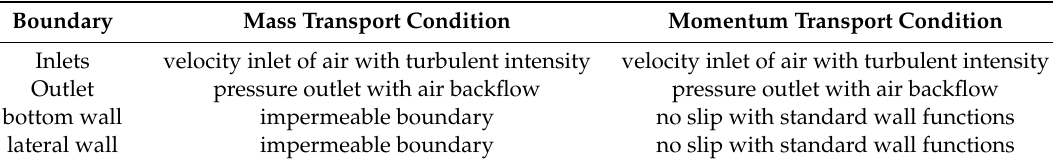
Table 1. Boundary conditions used in the numerical model presented in this study.